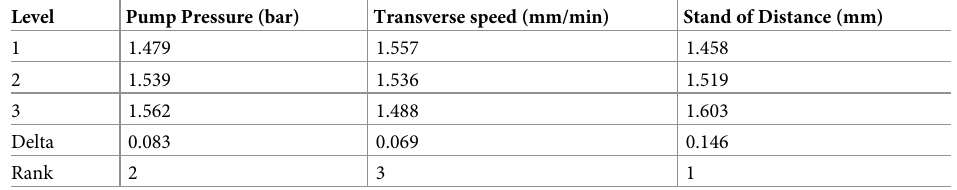
Table 3. Response table for glass fibre epoxy